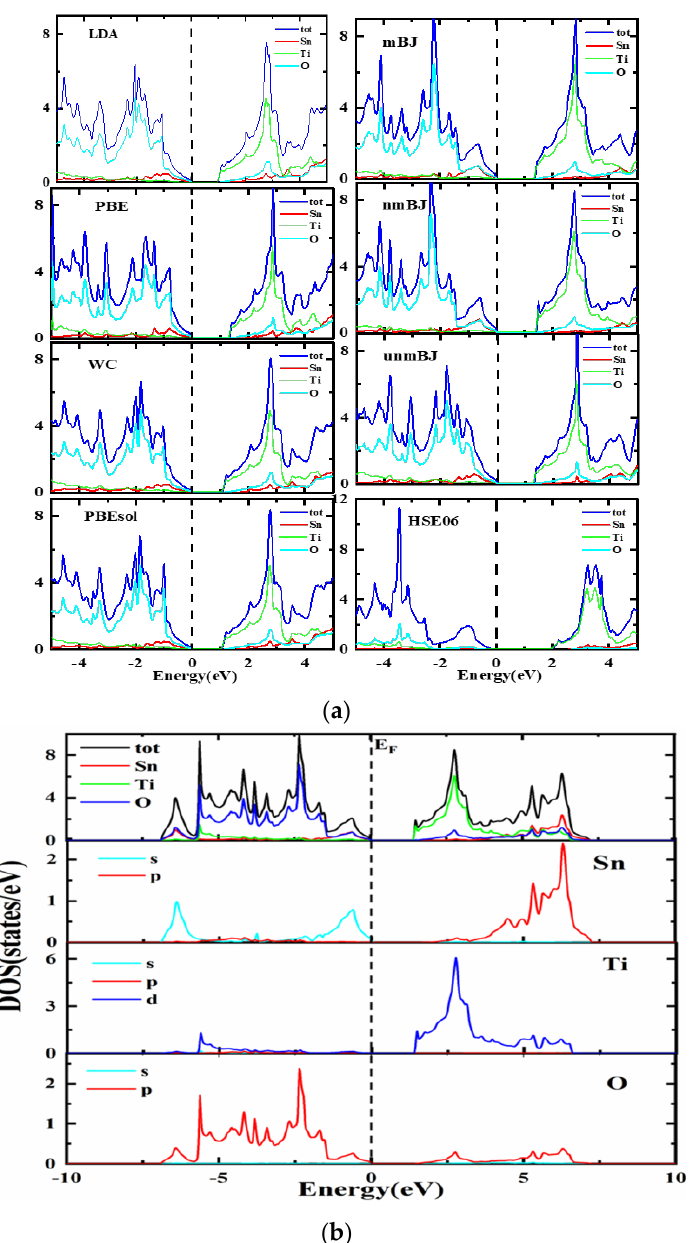
Figure 4. ( a ) Total DOSs for SnTiO 3 obtained using the LDA, PBE-GGA, WC-GGA, PBEsol-GGA, mBJ, nmBJ, unmBJ, and HSE06. ( b ) Partial density of states (PDOS) for SnTiO 3 obtained using the nmBJ-GGA potential.